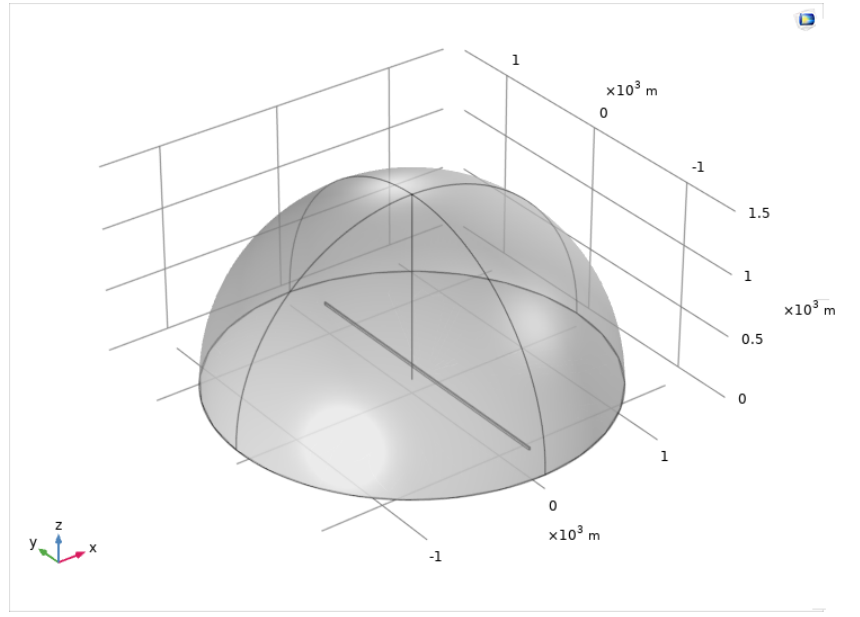
Figure 2. 3D FEM